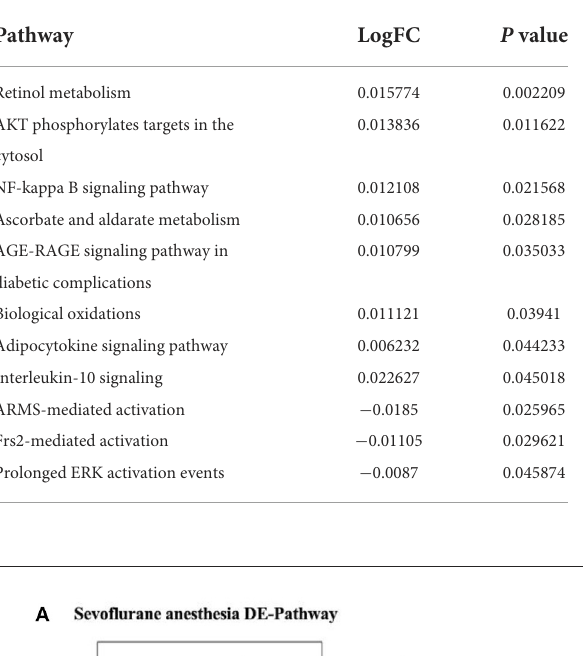
TABLE 3 Sevoflurane anesthesia DE-pathway.